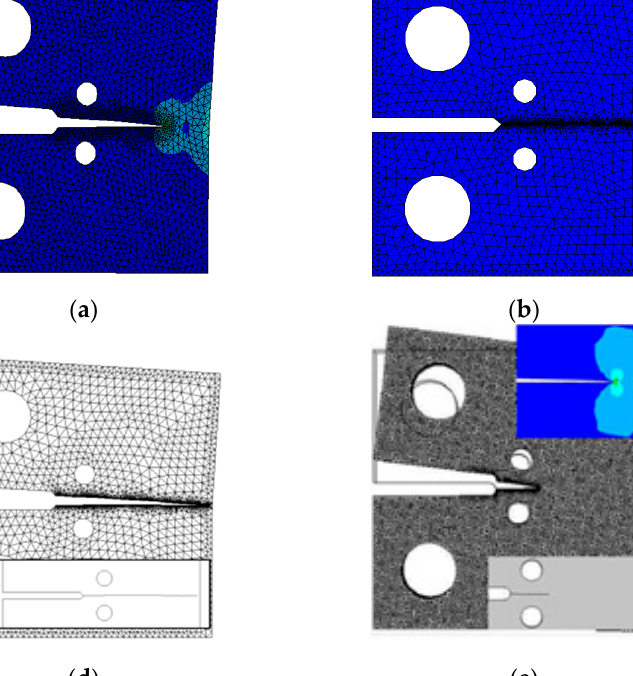
Figure 16. Predicted crack growth path for G7 specimen ( a ) ANSYS Workbench, ( b ) FRANC2D/L and ( c ) Experimental [32], ( d ) numerical [33], ( e ) FRANC3D [32].